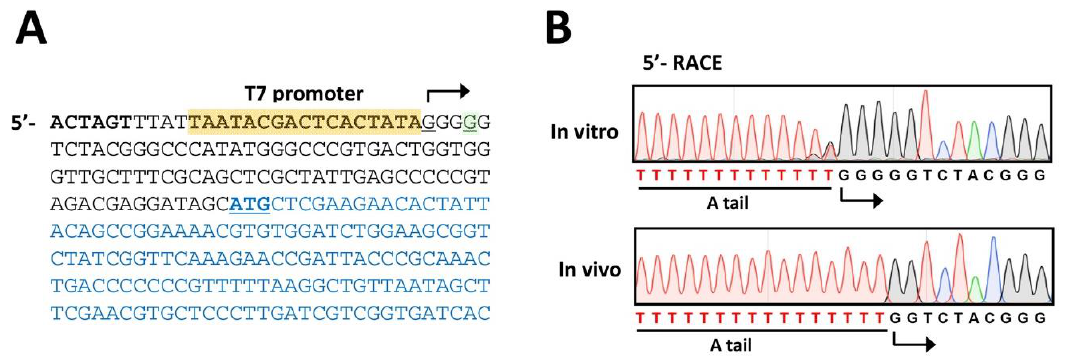
Figure 4. Verification of the phage genomic RNA. ( A ). Nucleotide sequence of the 5′ -region of the cloned PP7 cDNA. The T7 promoter is designated as yellow-shaded with the transcription start site (G. underlined) with bent arrow, which is located at the −3 position from the 5′ -end (G. underlined) of the PP7 genome. The coding sequence of the maturation protein is shown in blue with the start codon (ATG) underlined. The SpeI site is designated in bold. ( B ). Sequencing chromatogram of the 5′ -RACE products of the PP7 RNA obtained from the culture supernatant of PAK(PP7) (in vivo) in comparison with those of the in vitro transcribed RNA from the PP7 cDNA by T7 polymerase (in vitro). The T-tract represents the sequence from the poly- A tailing (A tail) at the 3′ -end of the RT products from both RNA samples.